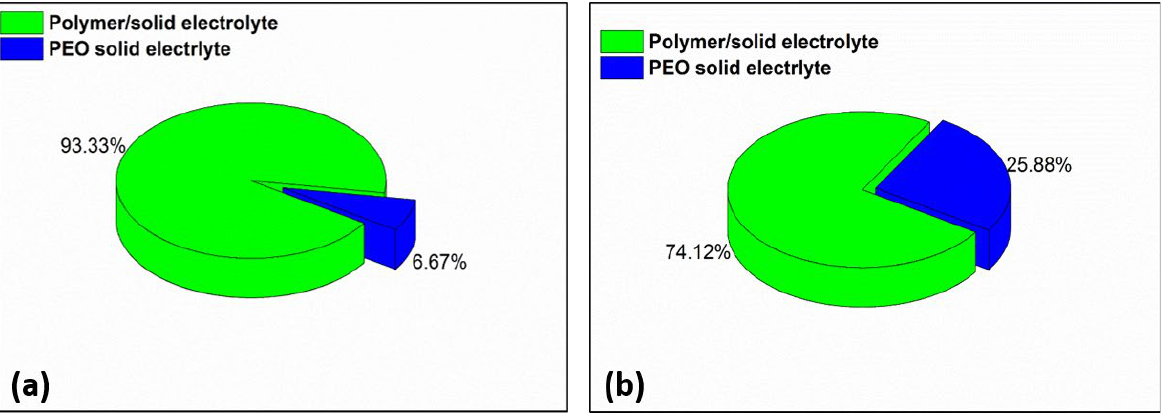
Figure 9. Comparison of distribution of patents on the topics of polymer/solid electrolytes and PEO solid electrolytes in 2010 ( a ) and 2020 ( b ).